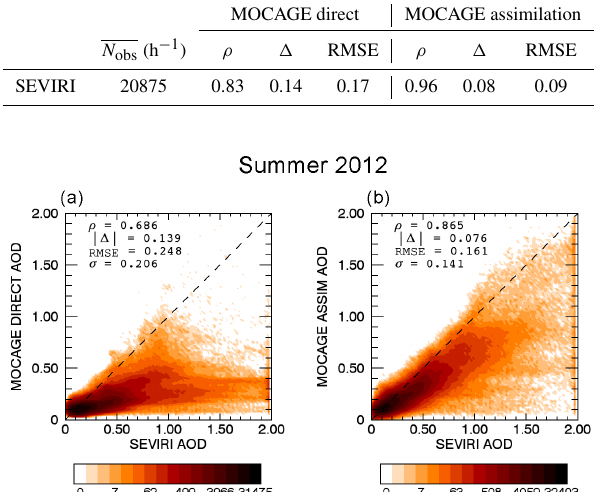
Figure 4. Scatter plots of aerosol optical depths (where colours represent the number of points) from the independent observation dataset (SEVIRI) and the simulations: the direct model run (a) and the assimilation model run (b) . In each panel, correlation ( ρ ), ab- solute bias ( (cid:49) ), root mean square error (RMSE) and standard devi- ation ( σ ) are noted. The included data correspond to the period of the TRAQA campaign from 25 June until 13 July 2012, and cover the whole MEDI02 domain.